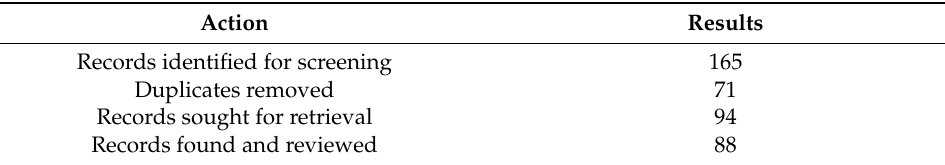
Table 2. Records identified from the literature